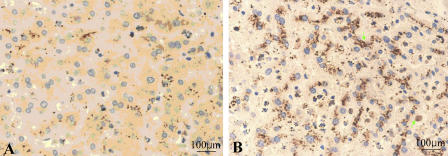
Immunohistochemical Analysis of Liver Tissue Sections from Dead Patients Incubated with Normal and
S. suis 2-Infected Swine Serum
(A) Staining with normal swine serum detected no
S. suis 2 antigen.
(B) Staining with the serum from the infected swine indicated the presence of
S. suis 2 antigen.